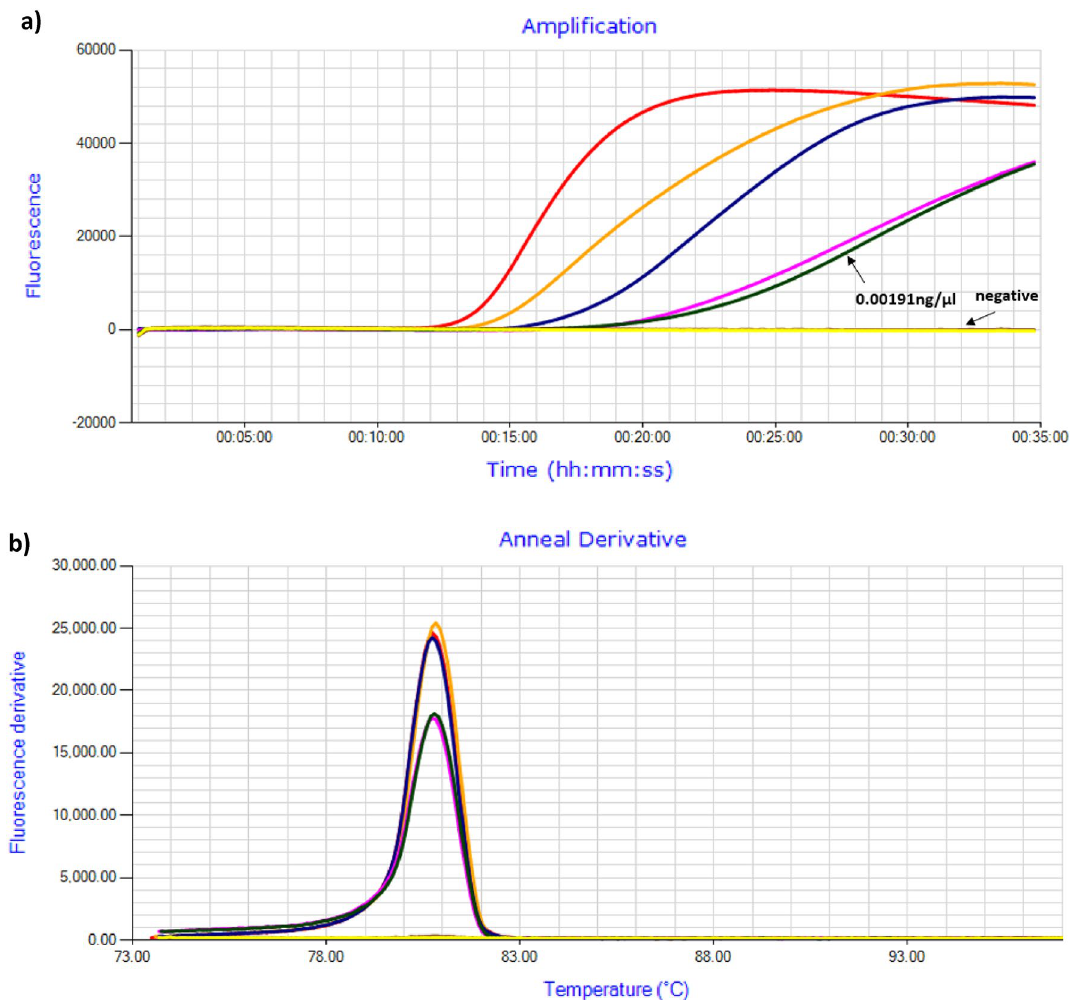
Figure 5. Detection sensitivity of C. brevis biological positive control amplicons. ( a ) Amplification profile with template concentration ranging from 19.1 to 0.00019 ng/µl at ten-fold dilution. ( b ) Annealing derivative of LAMP amplicons with an anneal derivatives of 80.7–80.8